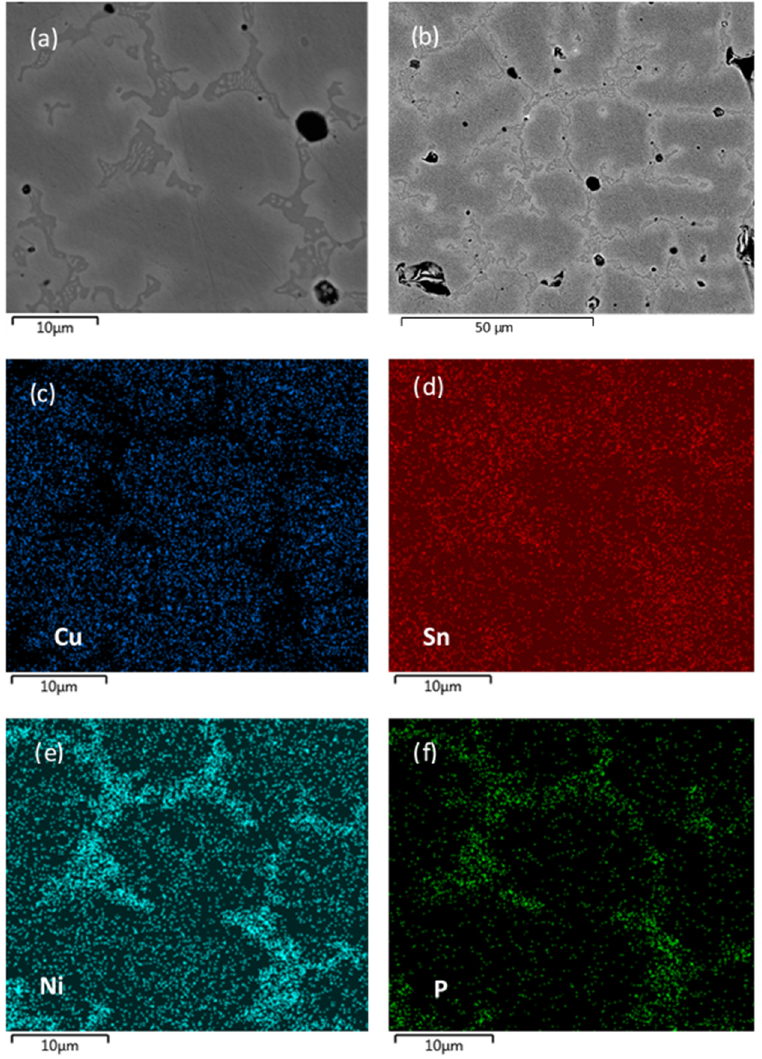
Figure 8. SEM and EDS images, showing a typical scanning LMH–AM grain structure ( a , b ), and the non-uniform spatial distribution of the main powder ingredients copper, tin, nickel, and phosphorous, in ( c – f ), respectively. A mutually complementing pattern, typical to selective melting processes, is observed in this case.